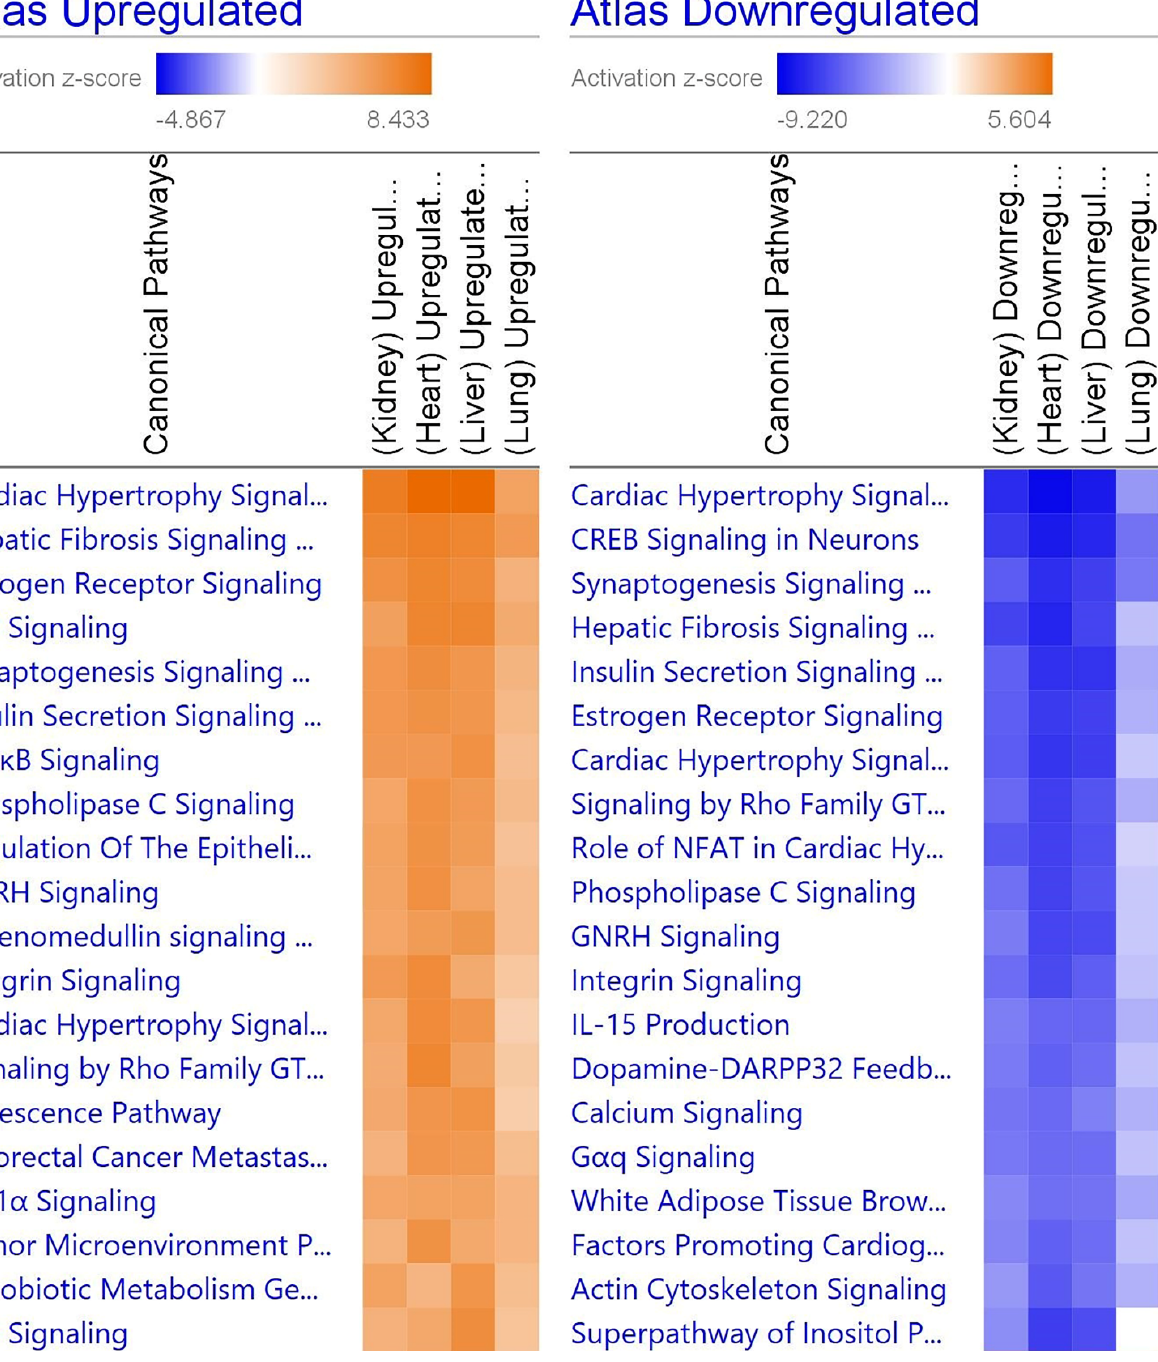
Figure 4. Heatmap comparing the top 20 pathways in organs. Orange indicates upregulation while blue indicates downregulation, and a stronger color indicates a stronger effect. Gray indicates that the software was unable to predict the effect. The repeated pathways are due to individually down- or upregulated steps within the pathway. Generated in IPA from gene lists.